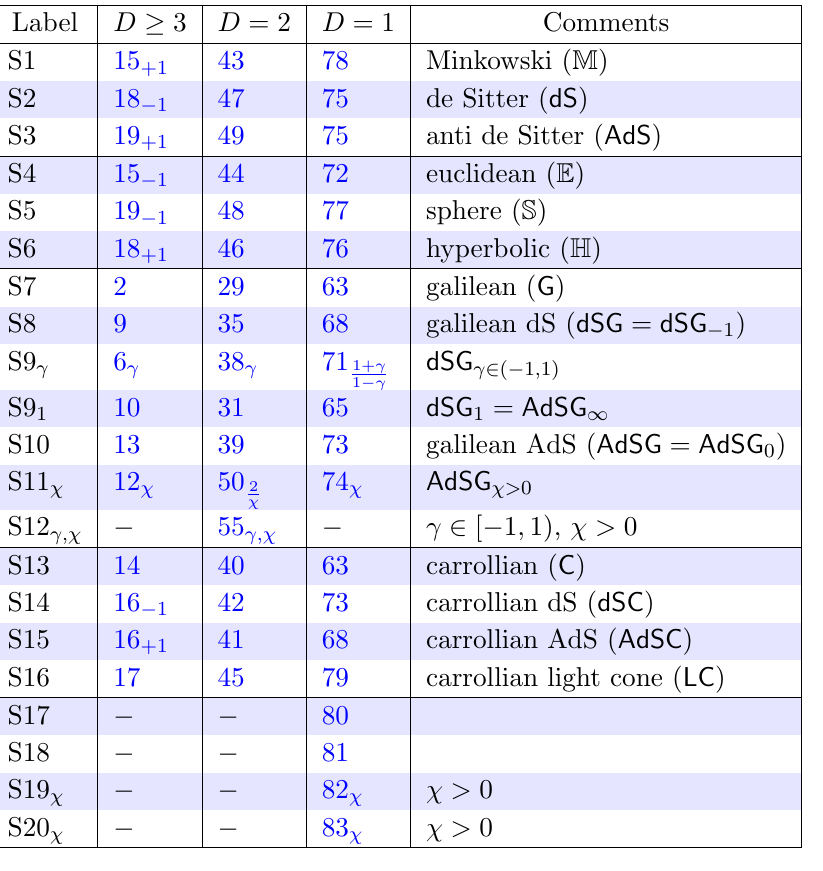
Table 14 . E(cid:11)ective kinematical Lie pairs.